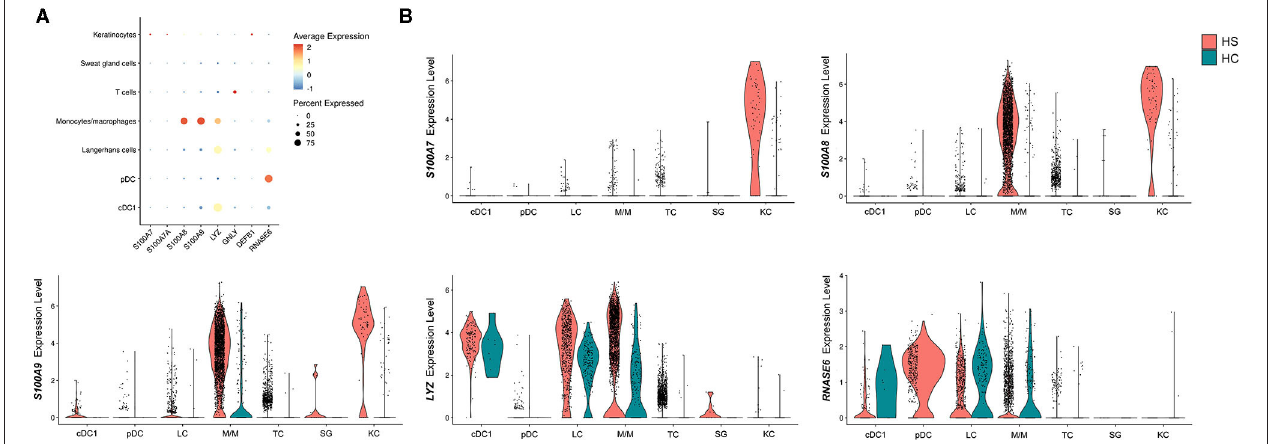
FIGURE 7 | Antimicrobial peptides and proteins are transcriptionally upregulated in key cell populations within HS skin lesions. (A) Dot plot showing the percent expressed and average expression of AMPs between key cellular populations in HS skin. (B) Violin plots of AMP expression within key cellular populations in HS and HC skin. AMP, antimicrobial peptides and protein; cDC, conventional dendritic cell; HC, healthy control; KC, keratinocyte; LC, Langerhans cell; M/M, monocyte/macrophage; pDC, plasmacytoid dendritic cell; SG, sweat gland cell; TC, T